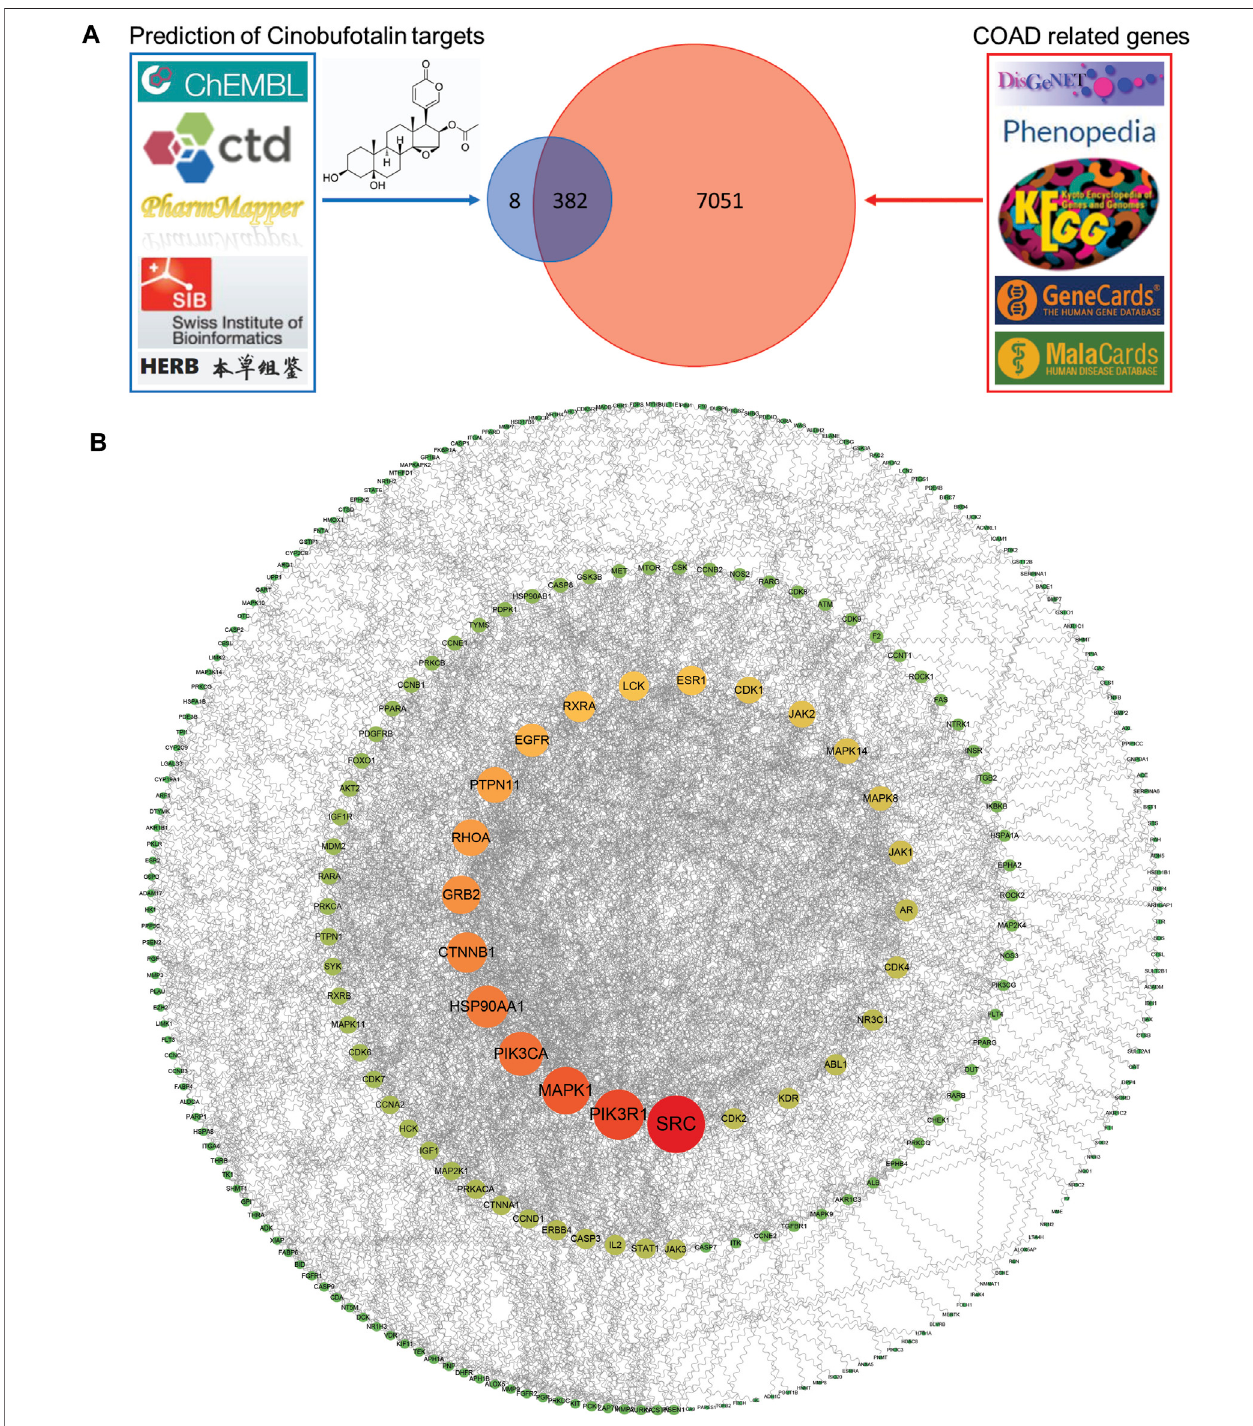
FIGURE 3 | Identi fi cation of the drug-target interactions (A) Identi fi cation of the targets by taking an intersection of cinobufotalin target genes and COAD-related genes from different public database as indicated (B) The PPI network was constructed for the shared candidate targets of cinobufotalin and COAD using Cytoscape.